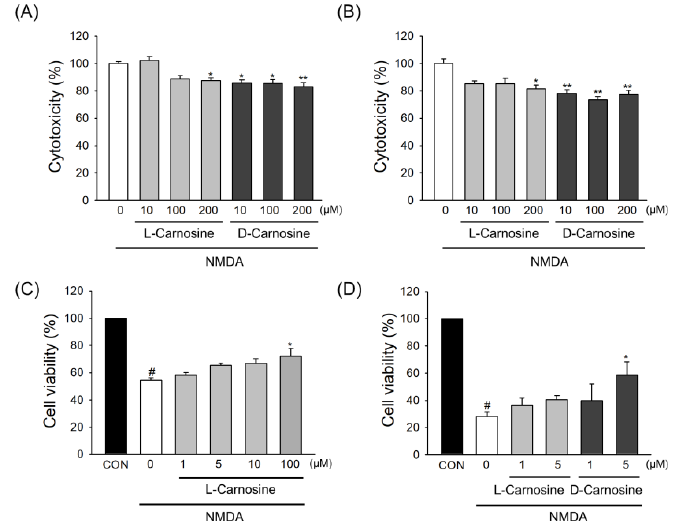
Figure 4. l - and d -carnosine reduce NMDA-induced excitotoxicity in primary mouse and rat neurons. (A and B) Primary neurons isolated from mice ( A ) or rats ( B ) were pretreated with l - or d -carnosine for 24 h prior to NMDA stimulation as described in Method. Wells were washed and original media release. ( C , D ) Cell viability was measured by MTT assay in primary mouse neurons treated with